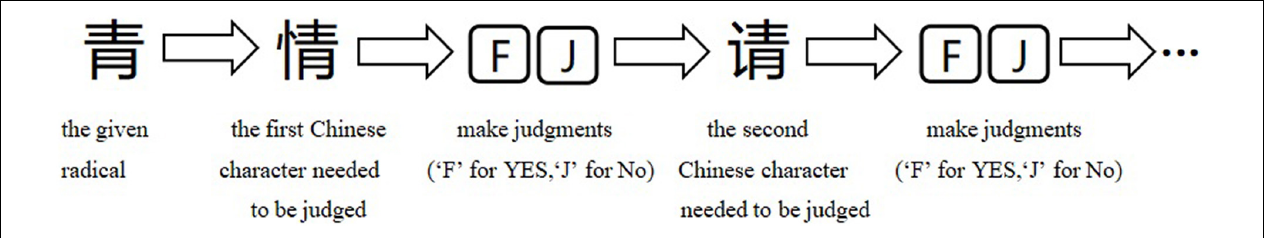
FIGURE 1 | Process of Chinese Hanzi recognition task. The participants were requested to make judgements on whether the presented Chinese Hanzi (10 characters in one group) included the given radical in each group. The stimuli were presented for 2.5 s followed by the appearance of a fixation cross for the other 2.5 s. For example, the given radical “ ” was presented to the participants first, and then “ ” was presented. The participants were required to make judgements on whether the Chinese character “ ” included the radical “ ”. Since “ ” included “ ” here, if the participants pressed “F” to show “yes” here, they made a correct judgment. Then the next character “